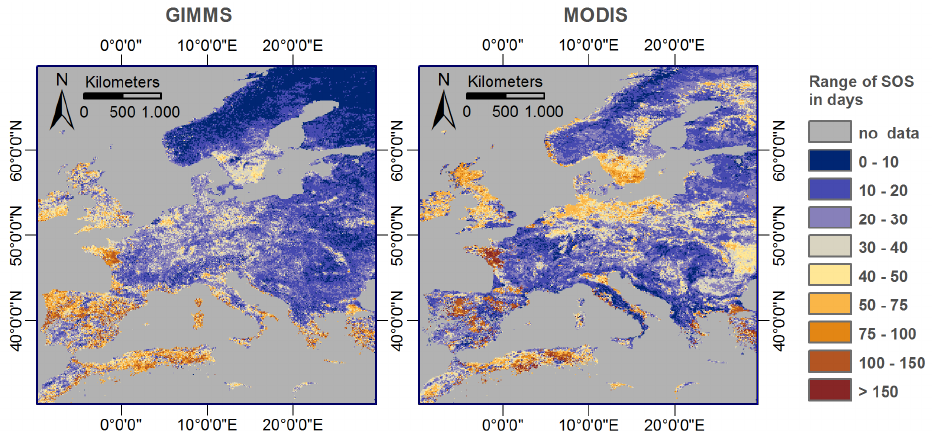
Figure 10. Range of estimated start of season (SOS) across nine years (2003–2011) for two time series (GIMMS and MODIS). The ranges are expressed in